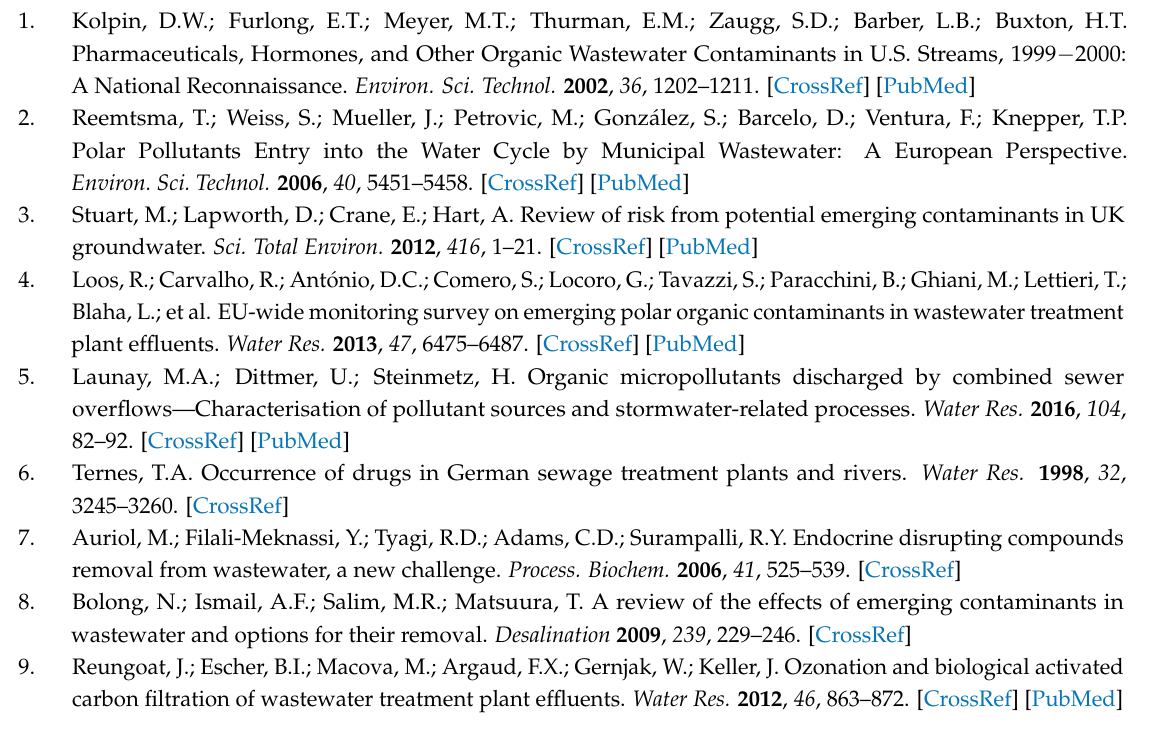
Supplementary Materials: Supplementary Data regarding influence of H 2 O 2 on total Cl 2 analysis, results of UV/chlorine AOP in literature and elimination of bacterial count are available online at